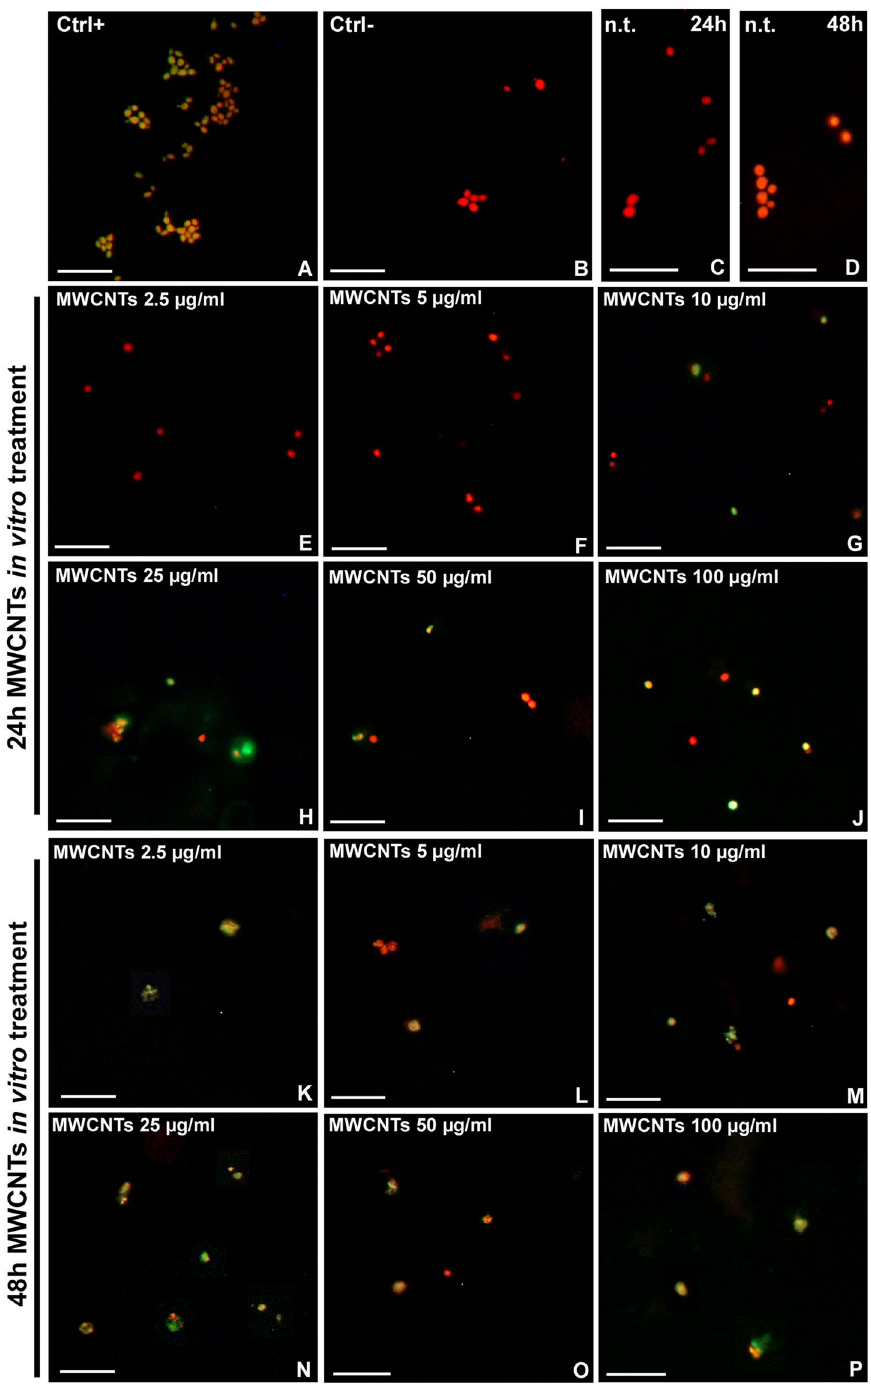
Figure 5. TUNEL assay for apoptotic nuclei detection after in vitro MWCNT treatment ( A – P ). DNase treated positive control ( A ). Negative control in which the primary antibody was omitted ( B ) and 24 h and 48 h n.t. samples ( C , D ). Cultured macrophages 24 h ( E – J ) and 48 h ( K – P ) after MWCNT in vitro treatment. Nuclei were counterstained with propidium iodide (red). TUNEL positivity is visible in green/yellow. Bars in ( A – P ) 20 µ